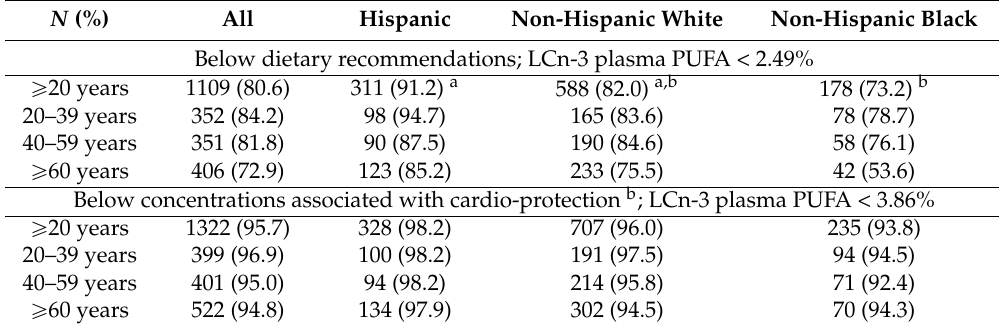
Table 3. Prevalence of inadequate LCn-3 levels for cardiovascular